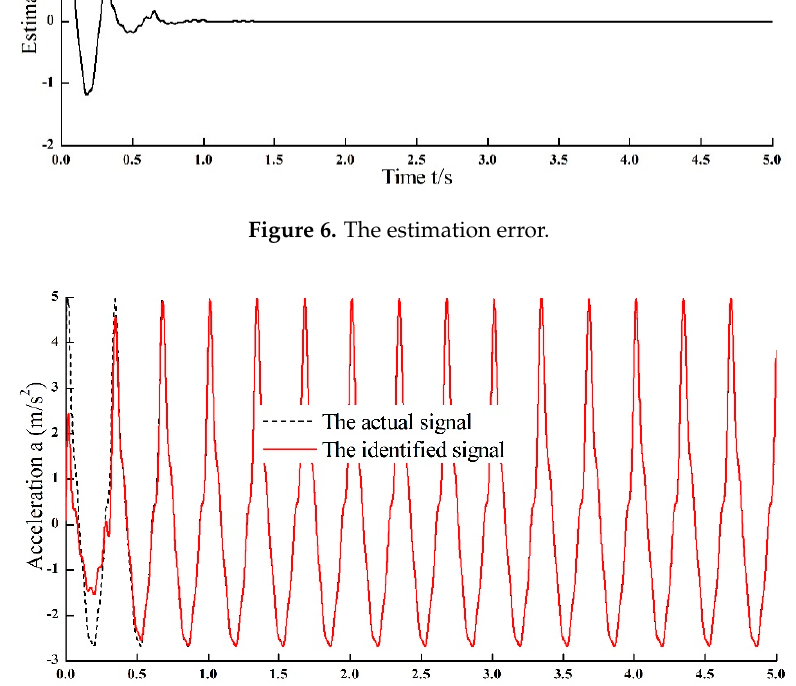
Figure 7. The identification acceleration.